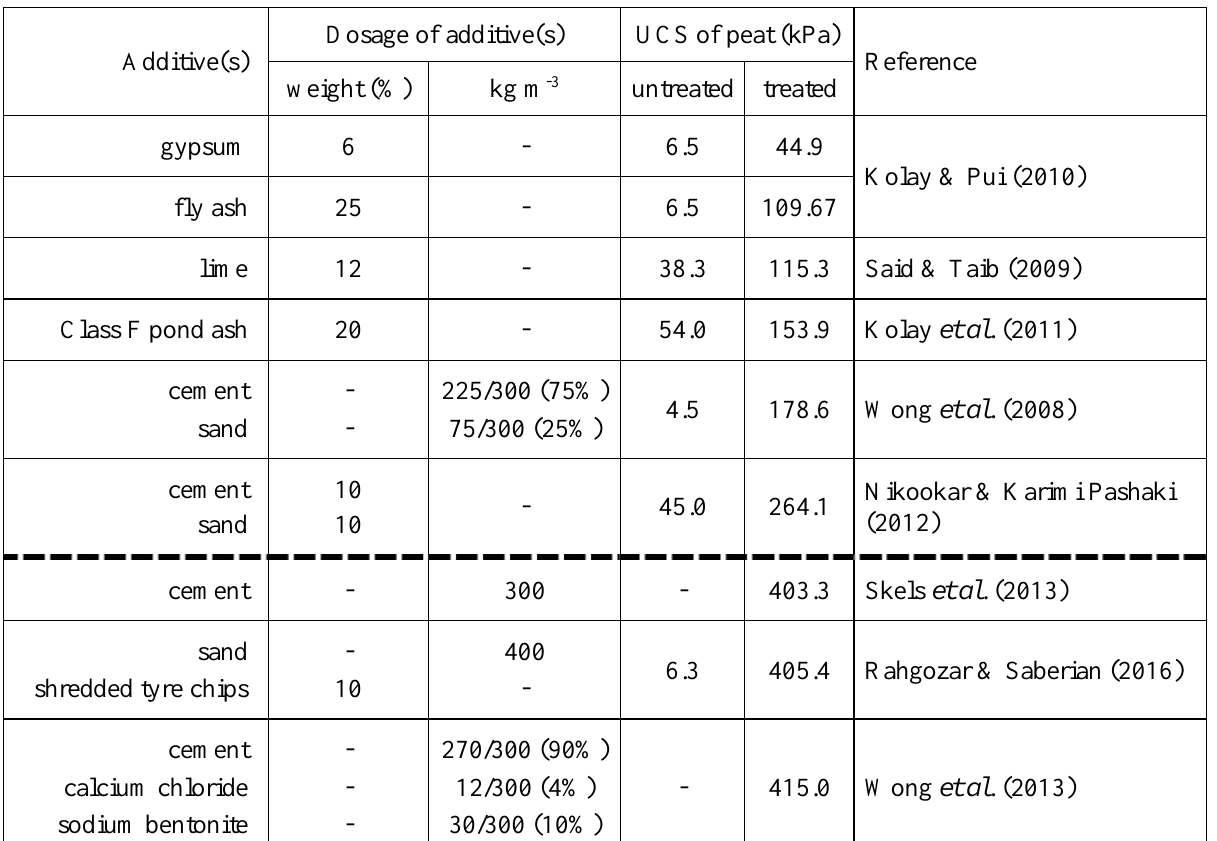
Table 1. Summary of some previous research on the use of different additives for stabilisation of peat soil, arranged in order of increasing UCS after treatment. The thick dashed line indicates the position in the list of the UCS threshold (345 kPa) set by the ASTM D4609